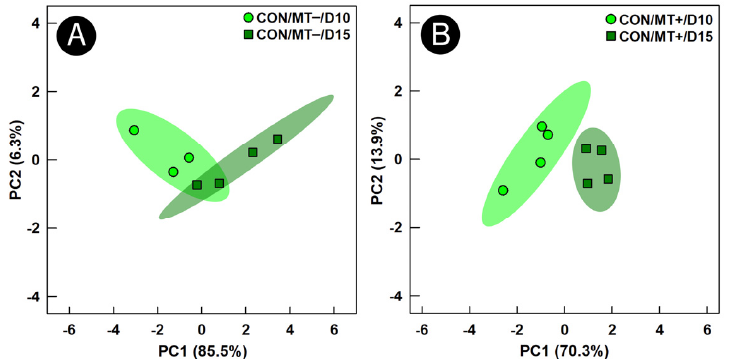
Figure 5. Principal component analysis score plots of metabolite bins in cecal digesta of broiler chicks administered an unamended starter diet (CON) and received a microbiota transplant (MT+) or buffer alone (MT–). Samples were analyzed 10 days post-hatch (D10) and 15 days post-hatch (D15). Each marker represents one bird, and the shaded ellipses represent 95% confidence intervals. The x- and y-axes show principal components one and two, respectively, with the number in brackets indicating the percent variance of each component. Metabolite bins were determined to differ ( p ≤ 0.050) according to a Univariate Mann–Whitney U-test. ( A ) CON/MT– Day 10 vs. Day 15; ( B ) CON/MT+ Day 10 vs. Day 15.